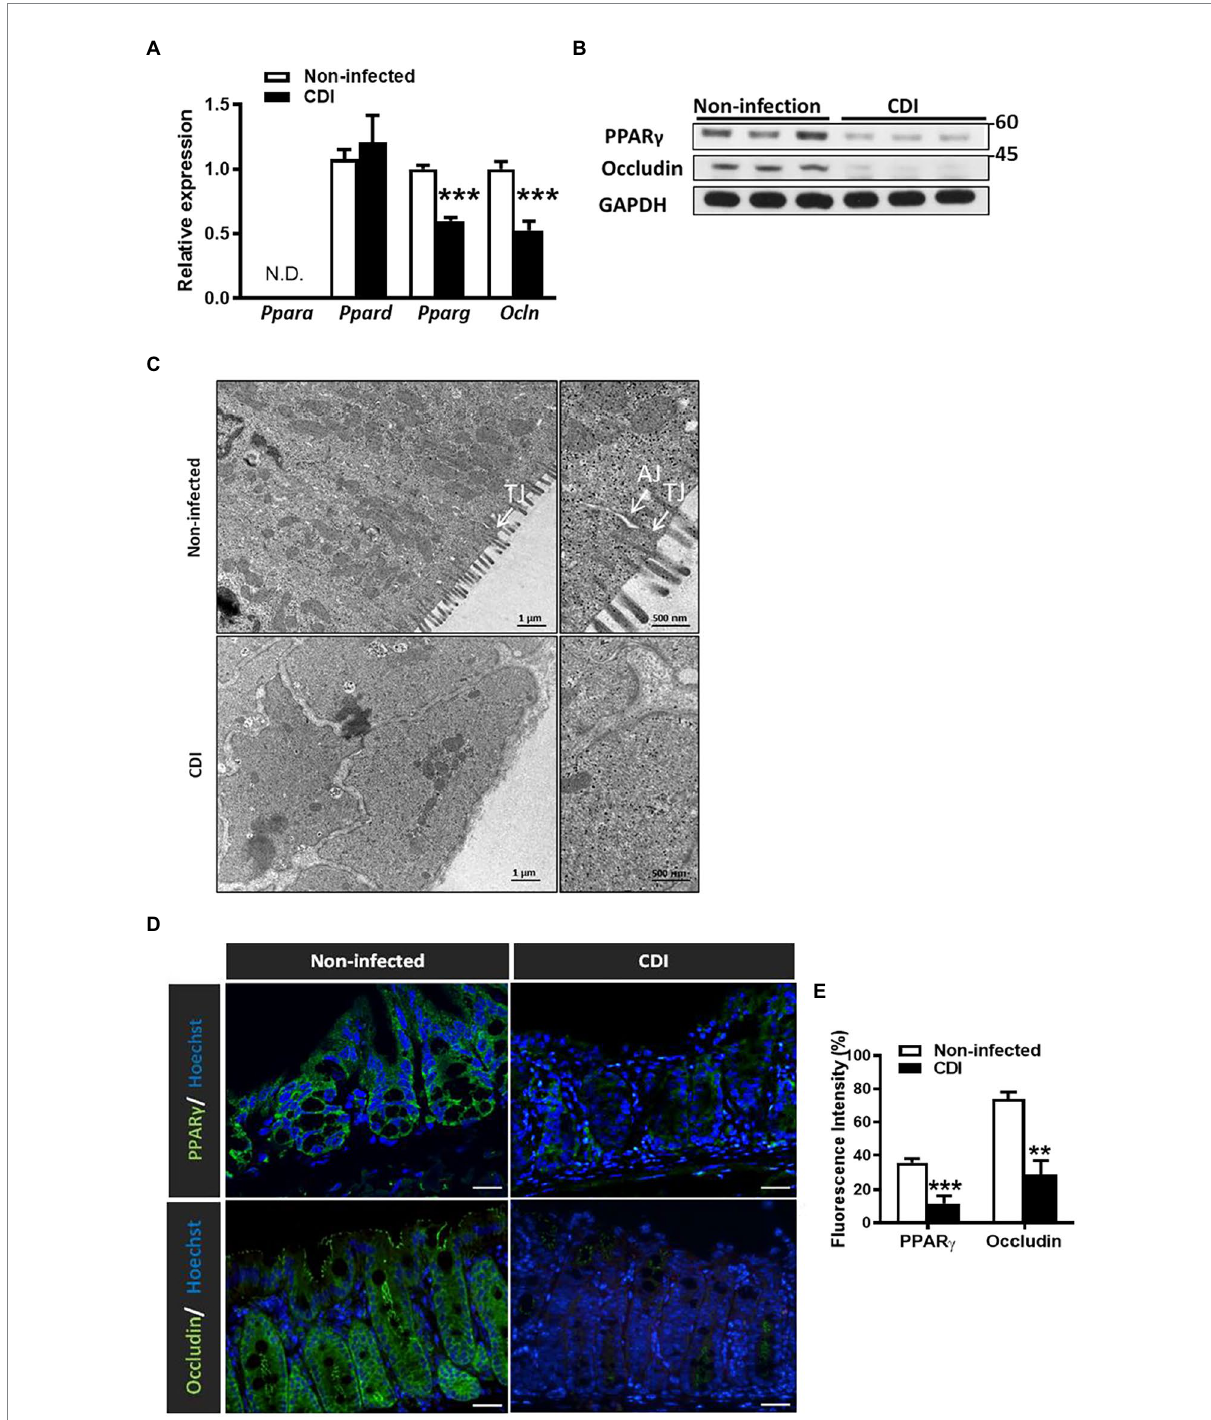
FIGURE 1 Downregulation of PPAR- γ and occludin in colonic tissue after CDI in C57BL/6JNarl mice. Seven to eight-week-old C57BL/6JNarl mice were orally inoculated with Clostridioides difficile for 48 h. (A) Real-time PCR of mRNA expression of PPAR family and occludin in colonic tissue. (B) Western blot analysis of PPAR- γ and occludin protein levels in CDI colon tissues. (C) Representative images of colonic tissue infected with C. difficile from mice via a transmission electron microscope. White arrows indicate the position of the tight junction (TJ) and adherens junction (AJ) on the microscopic images. Scale bars stand for 1 μ m and 500 nm. (D) Immunofluorescent staining of PPAR- γ (green), occludin (green), and Hoechst (blue) in colonic tissue of non-infected and C. difficile -infected mice. Scale bars stand for 20 μ m. (E) The percentage of the cells stained with PPAR- γ and occludin relative to the total number of Hoechst + cells were quantified with TissueQuest Analysis software, respectively. The immunofluorescent staining was quantified by five fields of views. Values are expressed as mean ± SEM (**, p < 0.01; ***, p < 0.001 relative to control group). All data are representative of three independent